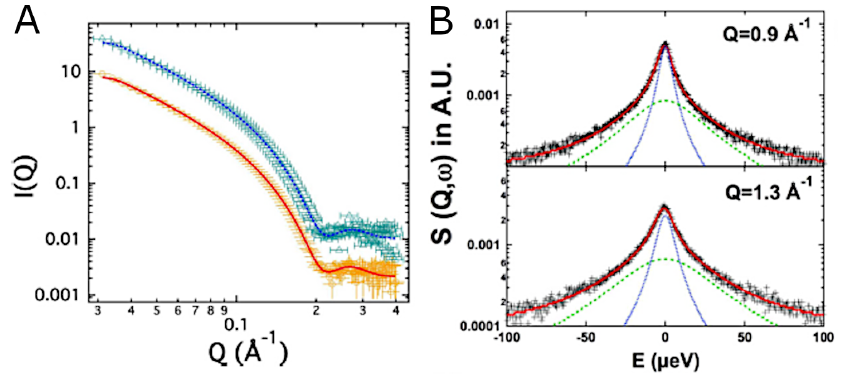
Figure 9. Impact of the amyloid β peptide on the structure and dynamics of DMPG membranes. ( A ) SANS data showing how the structure of the bilayer changes when peptide is absent from (orange) or present in (cyan) DMPG vesicles. ( B ) QENS data at two different q -values of DMPG vesicles with the amyloid β peptide. The figure is an adaptation of Figures 1a and 2a of reference [187] by Rai et al., which was published under the Creative Commons Attribution License (https://creativecommons. org/licenses/by/4.0/, accessed on 22 September 2022). The authors of reference [187] hold the copyright for the